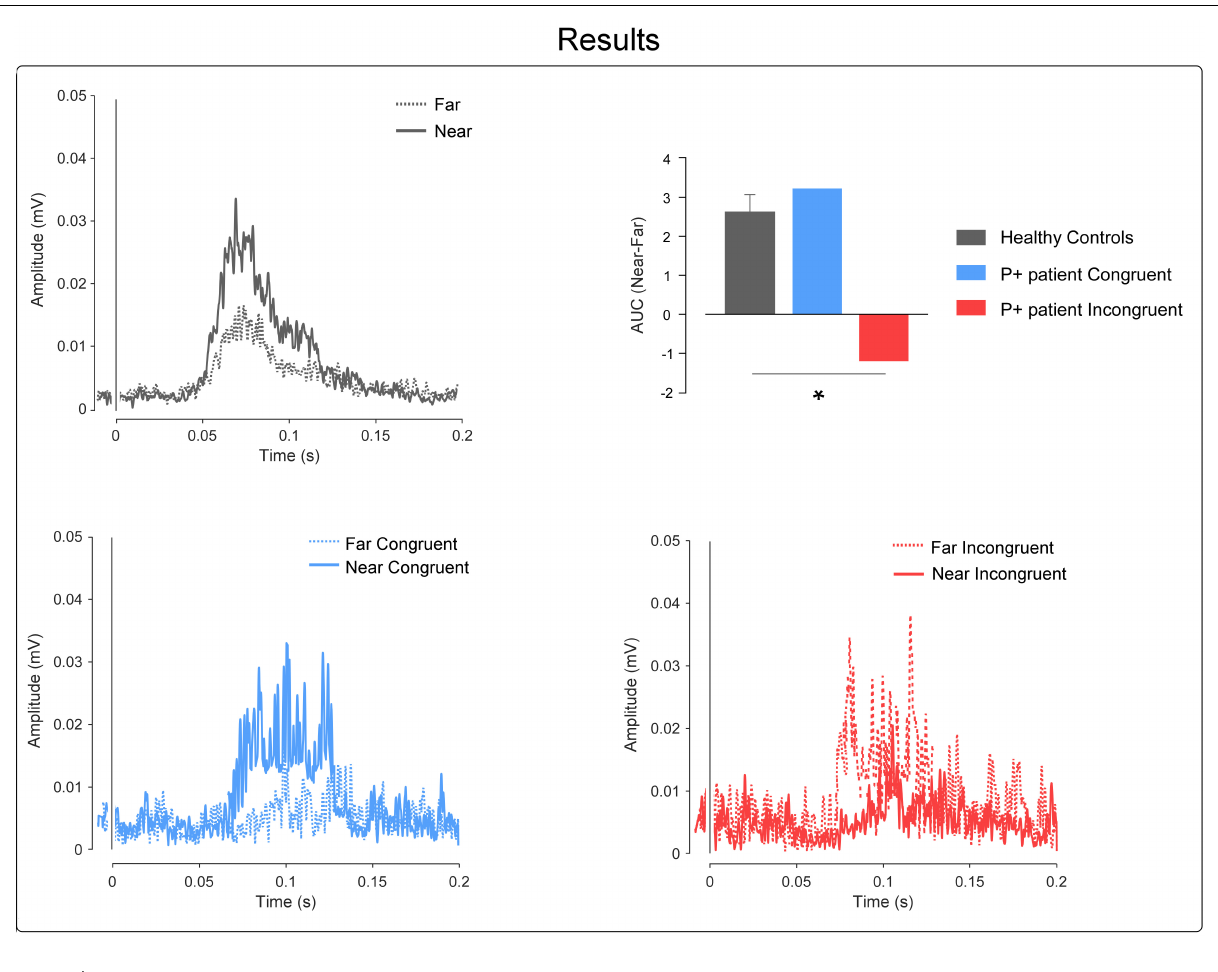
FIGURE 3 | Results. Top-left , the graph shows the control’s group-average rectified HBR waveforms; x -axis, Time (ms); y -axis EMG activity (mV). Top-right , the graph shows the AUC expressed as a difference between the near and far positions; in the controls group, we plotted the mean group AUC and error bar representing the standard error of the mean (SEM). The asterisk represents the results of the Crawford’s test ( ∗ = p < 0.05). Bottom , the graphs show the P+ patient’s rectified HBR waveforms in the congruent and incongruent conditions, respectively; x -axis, time (ms); y -axis EMG activity